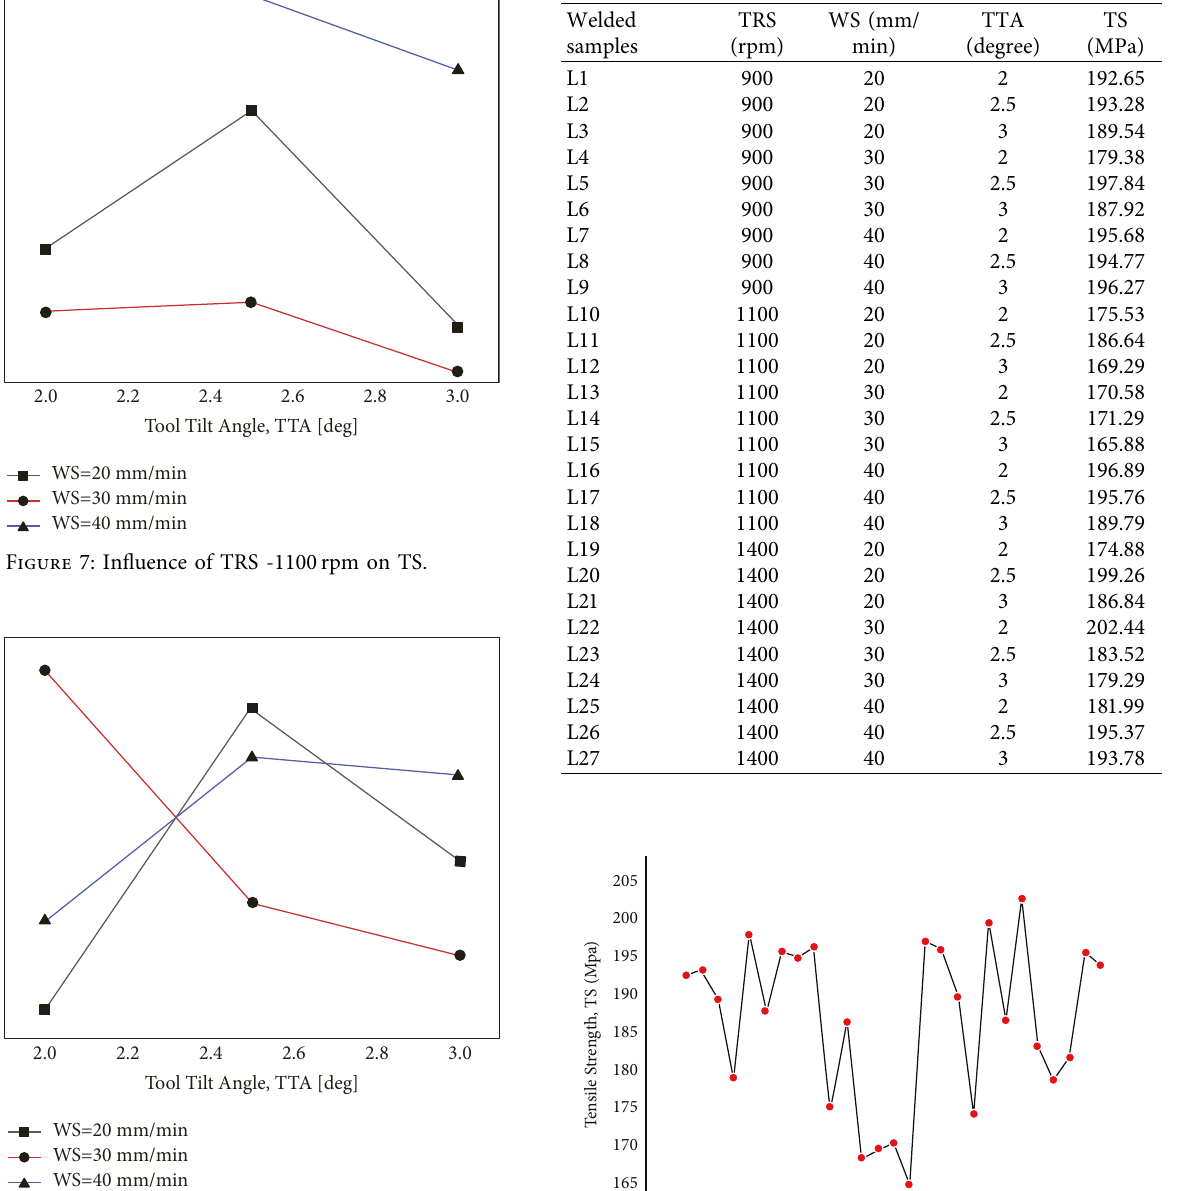
Table 4: Experimental observations.